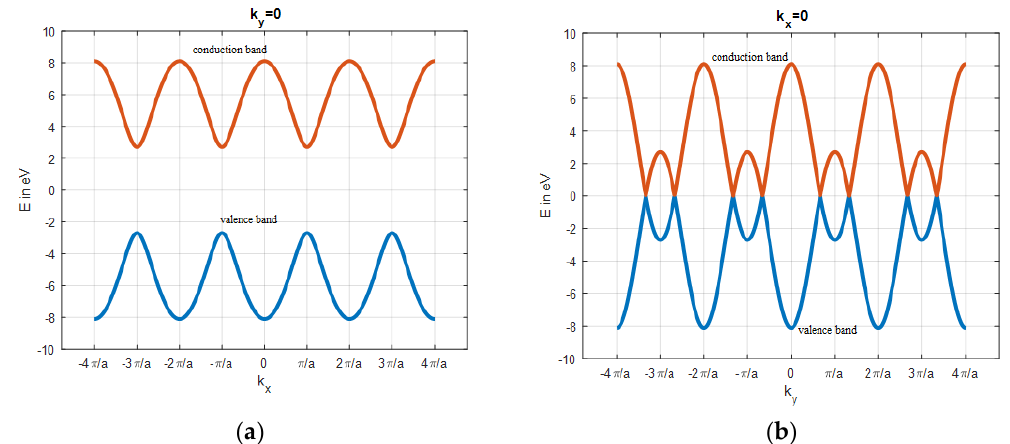
Figure 4. Band structure of graphene. ( a ) E – K surface plot for bulk graphene; ( b ) contour plot of conduction band.